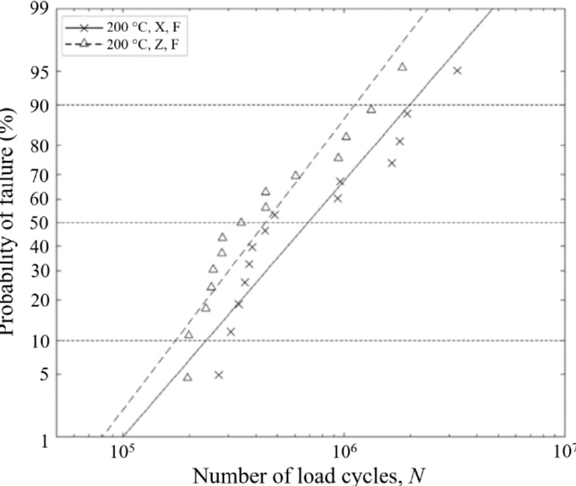
Figure 11. Probability of failure (%) vs. number of load cycles, N . The probability density function of log-normal distributions is fitted to each series of experimental results. The stress amplitude was 130 MPa for the 200 °C, X and Z building conditions.